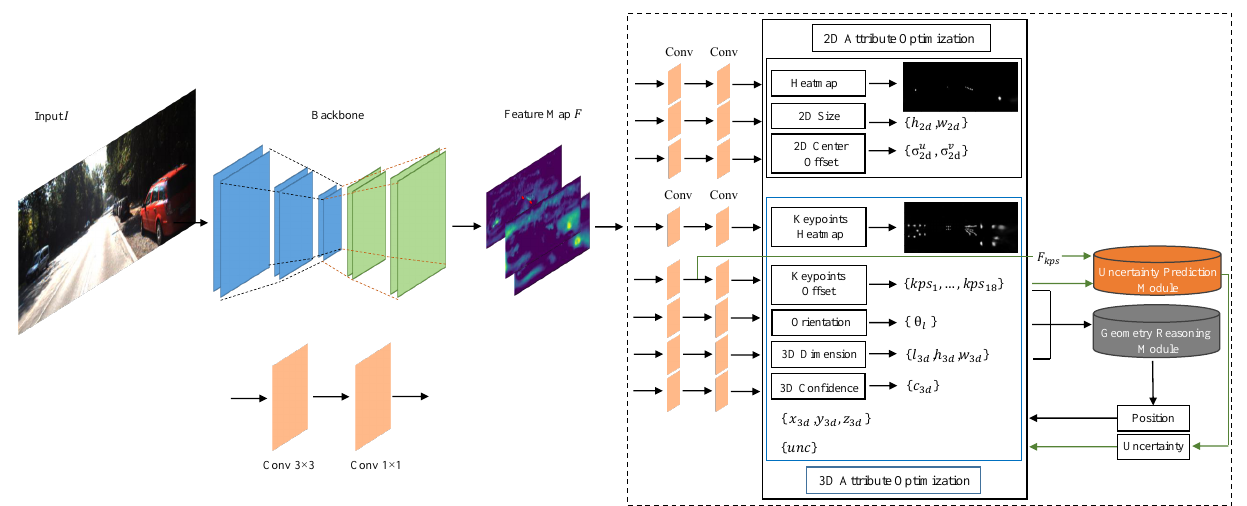
Figure 1. Overview of our network architecture: the backbone is composed of DLA-34 followed by eight sub-task components, the 3D object position is solved by the geometric reasoning module, and the uncertainty module is used to predict the uncertainty for joint optimization in the position loss.